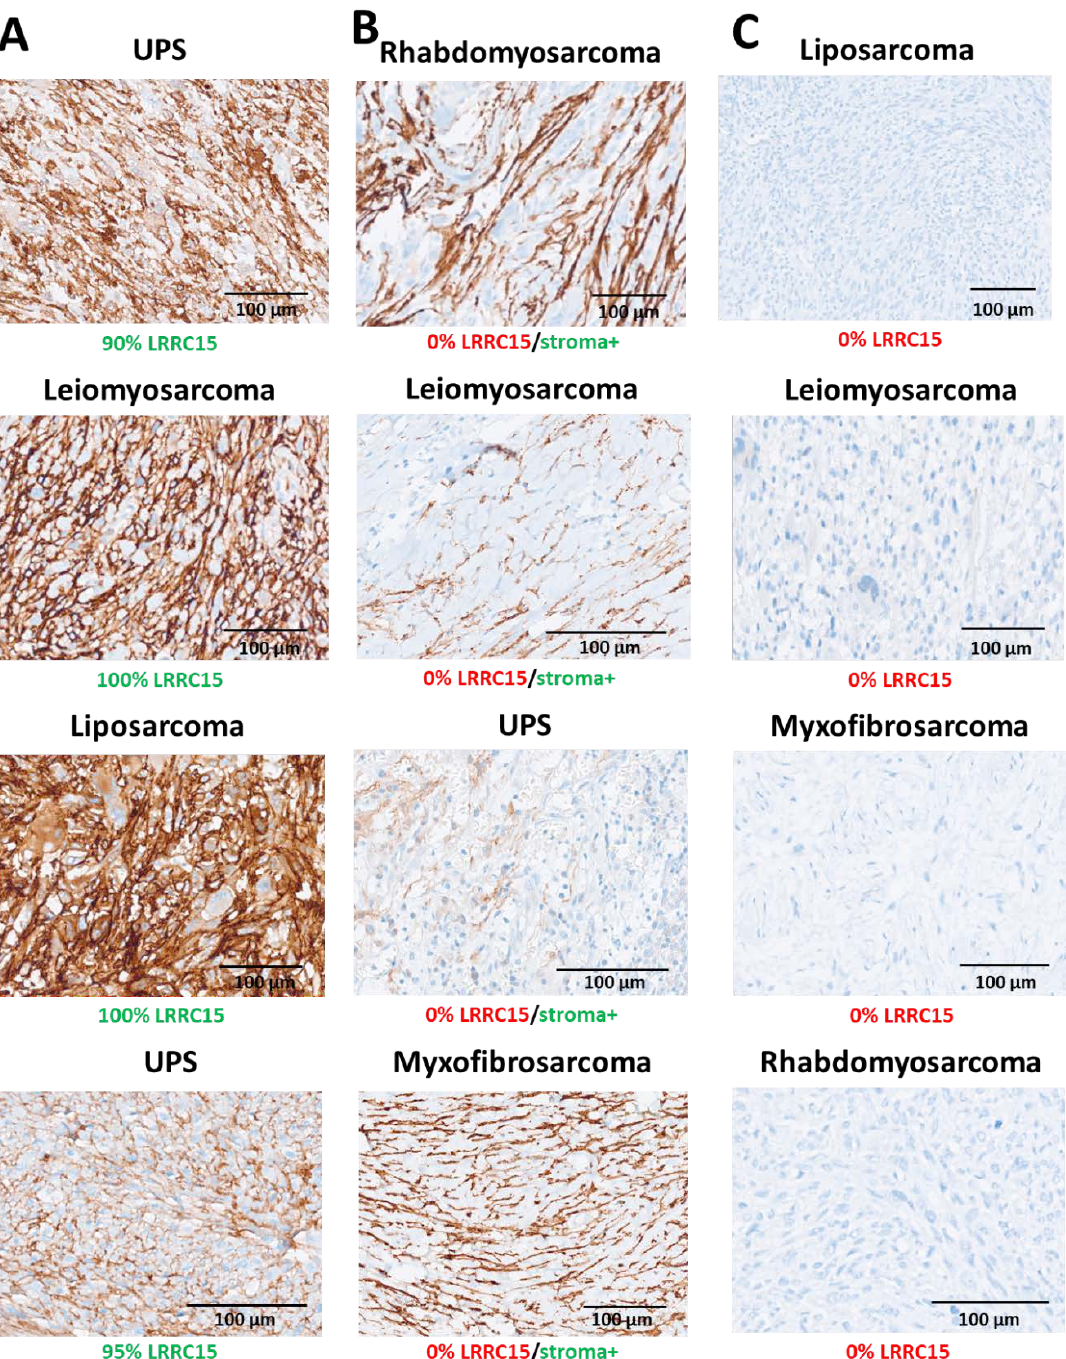
Figure 1. LRRC15 staining obtained by immunohistochemistry for different histological subtypes of soft-tissue sarcomas (STS) with different level of expression in cancer cells and stroma. ( A ) Examples of STS with a significant expression in cancer cells. ( B ) Examples of STS without expression of LRRC15 in cancer cells but with an expression in the surrounding stroma. Staining was predominantly seen in spindle cells (fibroblasts) and in the extracellular matrix. ( C ) Examples of STS without expression of LRRC15.